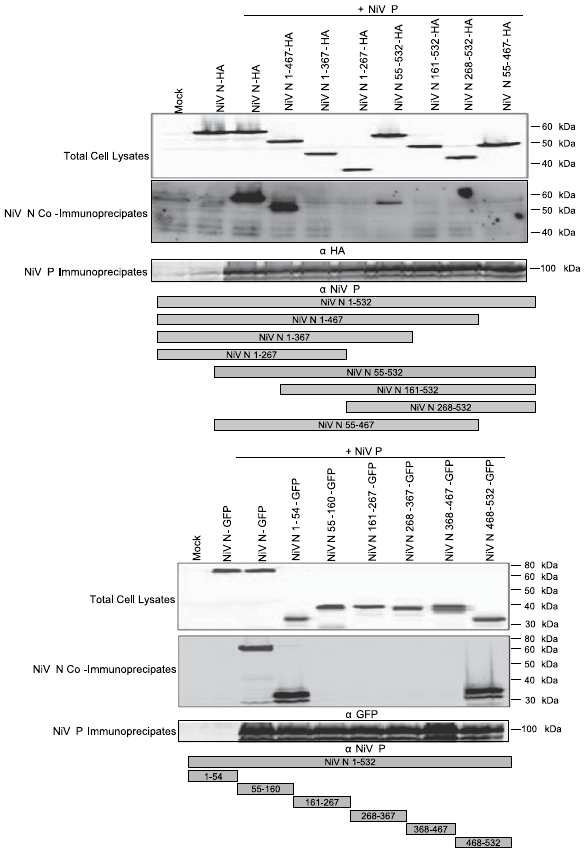
Figure 7. The ability of truncated NiV N proteins to interact with NiV P proteins. Cells were transfected with truncated NiV N constructs for 48 hours and protein expression was subsequently monitored from total cell lysates. A monoclonal antibody against NiV P was used to immunoprecipate NiV P proteins and co- immunoprecipate truncated NiV N proteins from cell lysates that transiently co-expressed ( a ) truncated NiV N proteins fused to an HA tag with NiV P proteins or ( b ) truncated NiV N proteins fused to GFP with NiV P proteins. Experiments were repeated at least three times. Blots have been cropped to ease